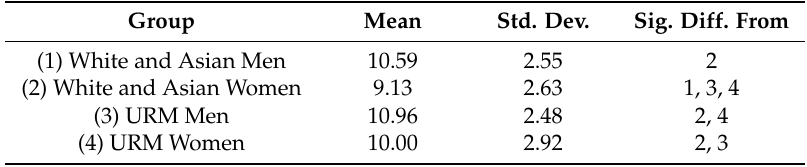
Table 1. Mean Differences in Incoming Sense of Belonging, by Gender and URM Status. Group Mean Std. Dev. Sig. Diff.